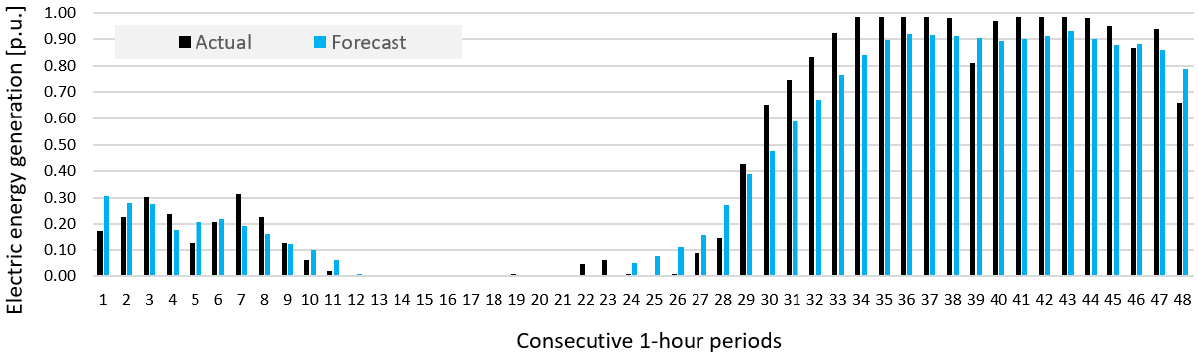
Figure 17. Two forecasts of electric energy generation for Wind Farm A made by INT_OUT_EXT [GBT, RF, PHYS(v1&v2) → KNNR, MLP, LSTM] method with additional expert correction for two consecutive days of an autumn month (November).